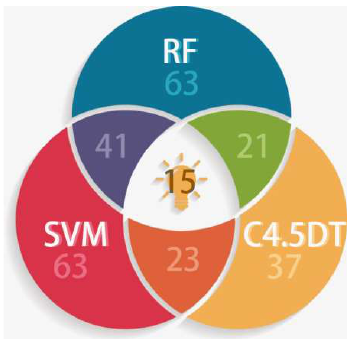
Figure 5. The number of descriptors selected by the models random forest (RF), C4.5 Decision Tree (DT) and support vector machine (SVM).